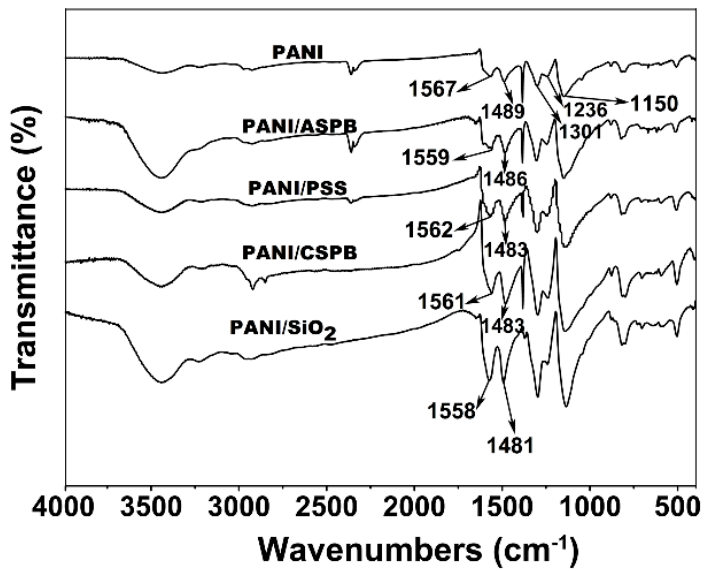
Figure 2. FTIR spectra of PANI, PANI/ASPB, PANI/PSS, PANI/CSPB, and PANI/SiO 2